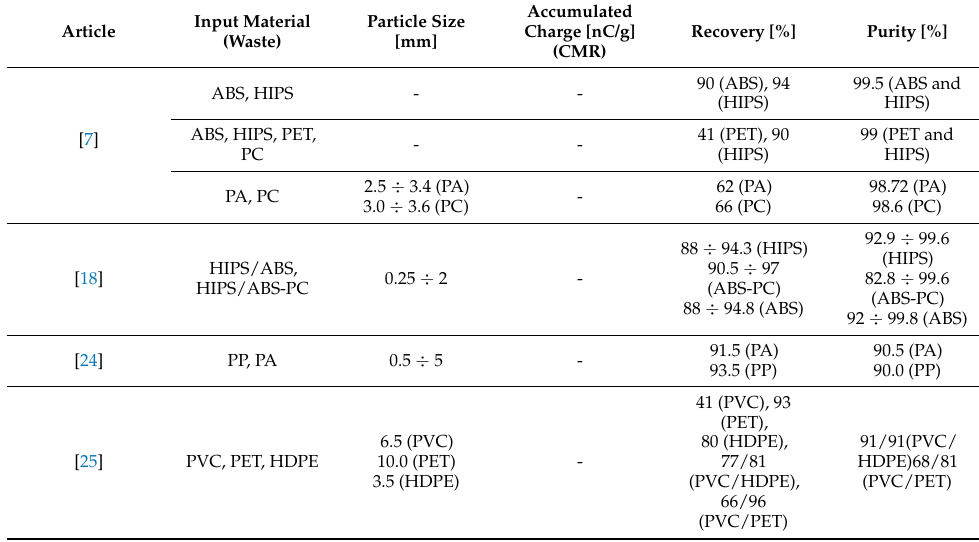
Table 1. Summary of selected parameters characterizing plastic waste separation on the basis of a literature